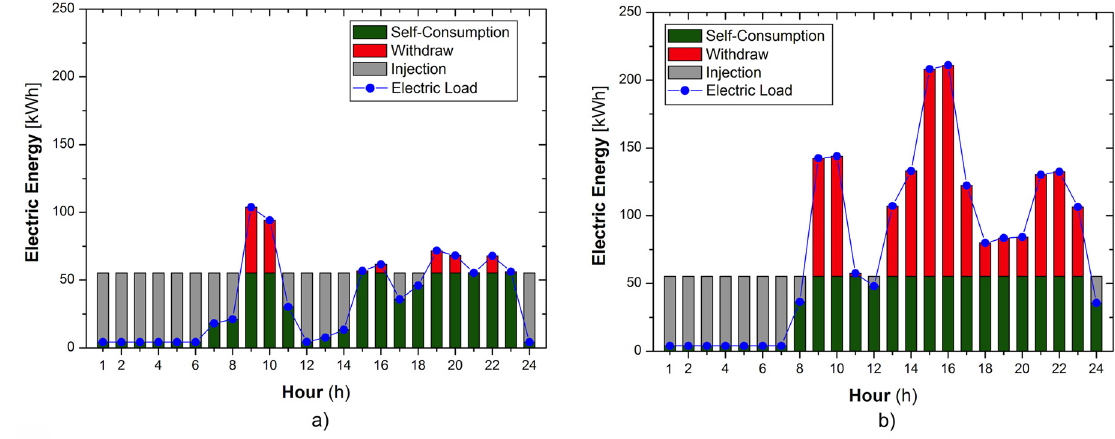
Figure 12. Hourly electric balance in winter ( a ) and summer ( b ) typical days. ORC electric production